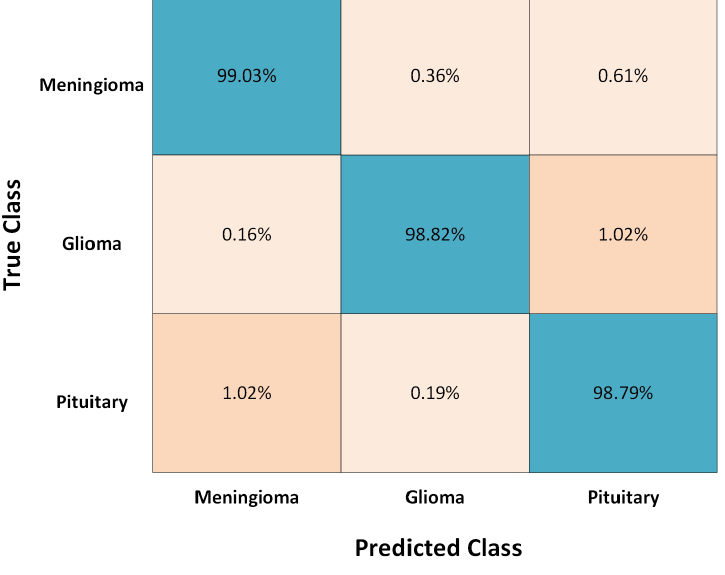
Figure 9. Confusion matrix for the classification of brain